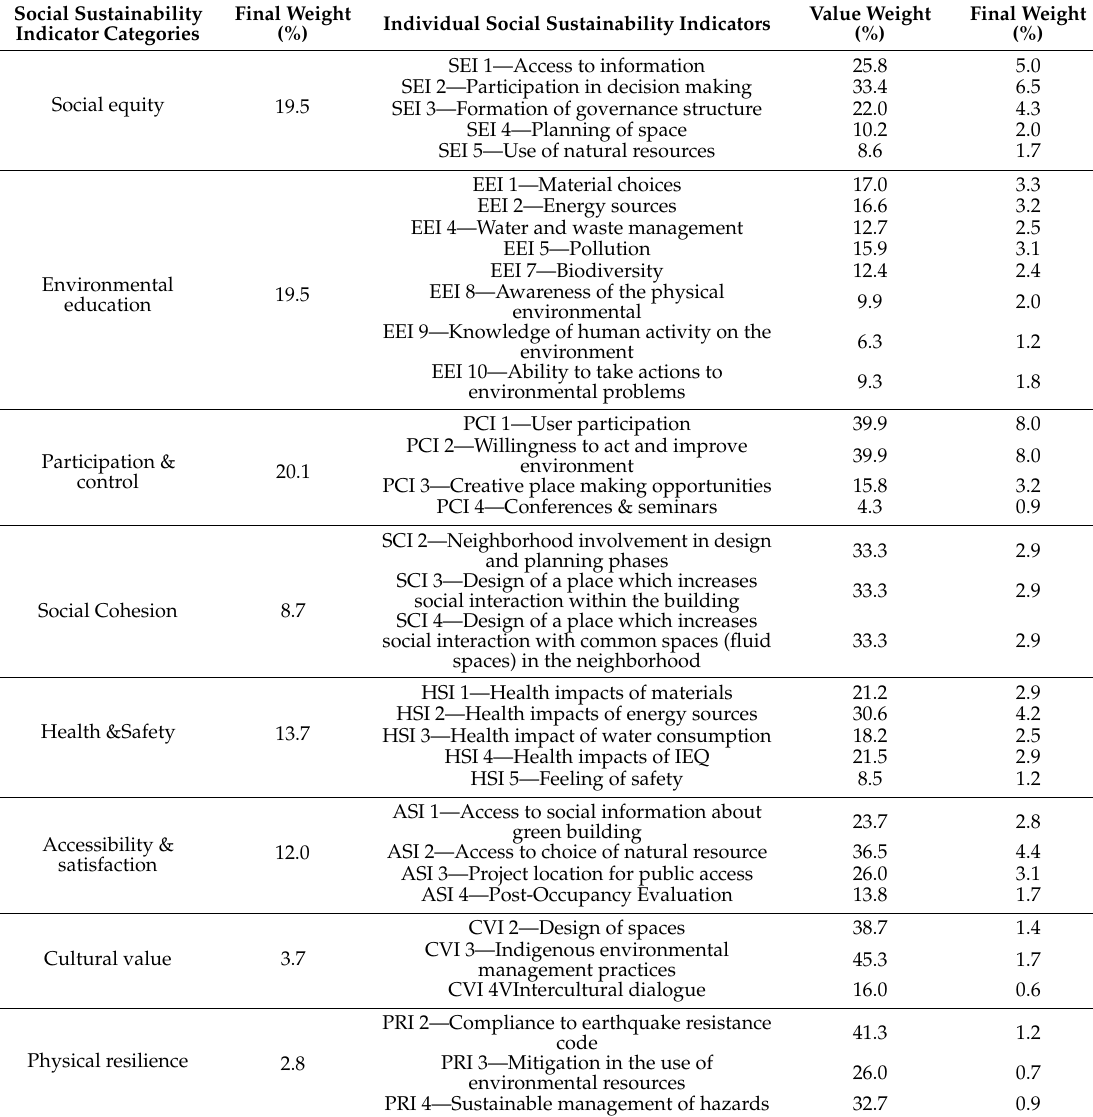
Table 2. Weighting score of the social categories and indicators